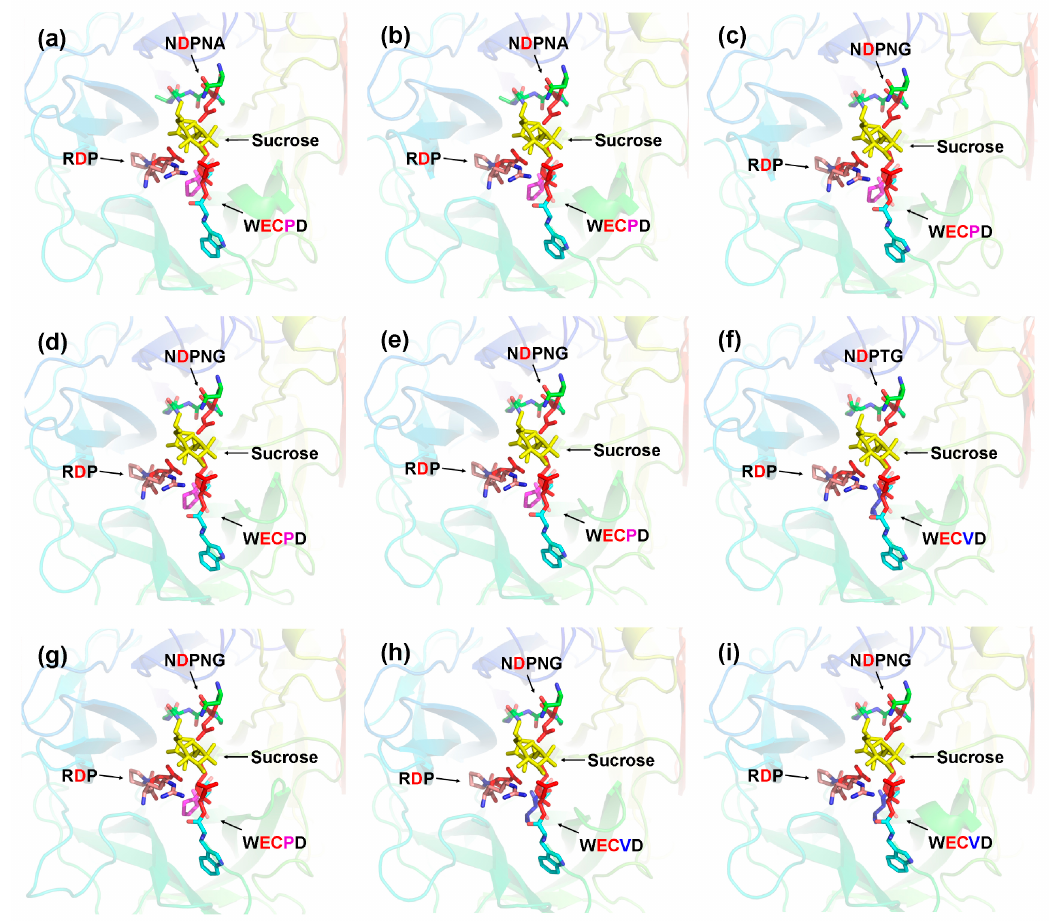
Figure 7. Predicted catalytic residues of CaAINV1 to 6 with sucrose molecules. ( a ) CaCWINV1; ( b ) CaCWINV2; ( c ) CaCWINV3; ( d ) CaCWINV4; ( e ) CaCWINV5; ( f ) CaCWINV6; ( g ) CaCWINV7; ( h ) CaVINV1; ( i ) CaVINV2. Yellow stick structures indicate sucrose molecules. The motifs (NDPNG, RDP, and WECP(V)D) are depicted by colored sticks. Red stick structures depict catalytic residues. The image was generated using the PyMOL program (Schrödinger, Inc., New York, NY, USA).